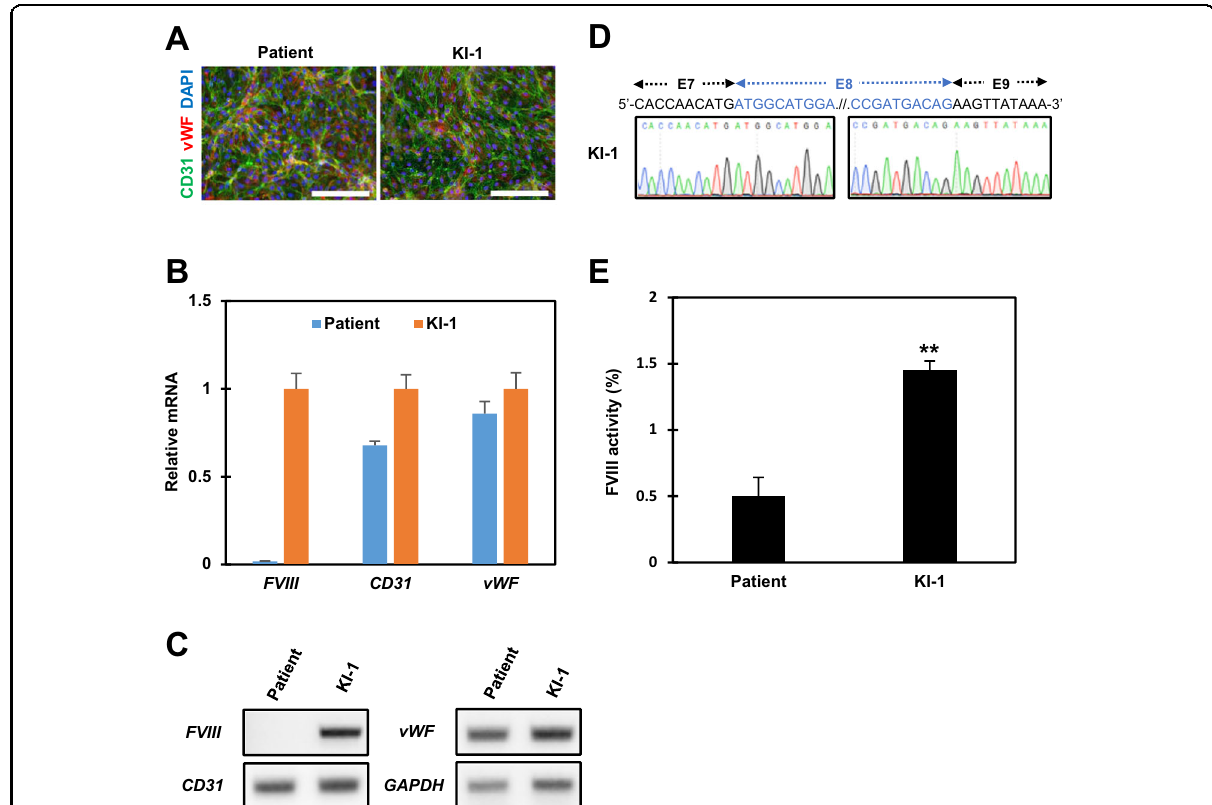
Fig. 3 Restoration of FVIII expression in the gene-corrected iPSC-derived endothelial cells. a Immuno fl uorescence staining of endothelial cell markers CD31 (green) and vWF (red) differentiated from the parental patient and gene-corrected iPSC clones. Nuclei were labeled with DAPI (blue) (scale bar, 200 μ m). b qPCR analysis of FVIII , CD31 , and vWF in cells from the patient and from gene-corrected iPSC line-derived endothelial cells. The FVIII transcript was ampli fi ed with primers based on exon 7 and exon 10. c Expression of FVIII and endothelial cell markers CD31 and vWF were analyzed by RT-PCR. Endothelial cells were derived from cells from the patient and gene-corrected iPSC lines. d Sanger sequencing analysis of FVIII amplicons from gene-corrected iPSC-derived endothelial cells with restored exon 7 – exon 9 sequence. e The FVIII activity of cell culture supernatants from either patient-corrected or gene-corrected iPSC-derived endothelial cells. FVIII activity was determined in 5 × 10 5 endothelial cells per single detection. ** p < 0.01 compared to the patient